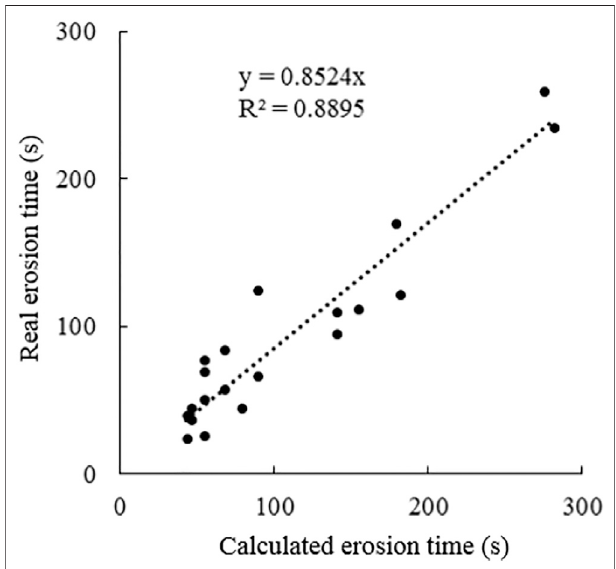
FIGURE 15 | Relationship between theoretical erosion duration and actual erosion duration.